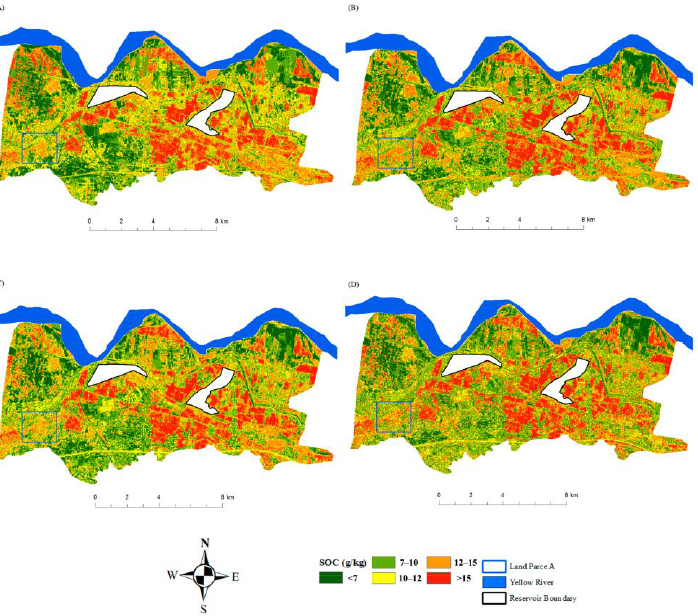
Figure 6. Spatial pattern of SOC in the study area based on ( A ) the ST model; ( B ) the STb model; ( C ) the STi model; ( D ) the STg model.